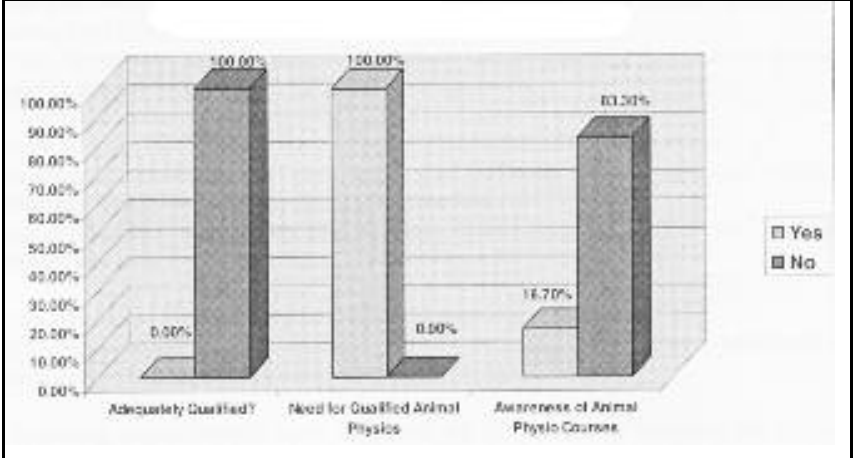
Figure 1: Graph indicating the views of physiotherapists’ on animal